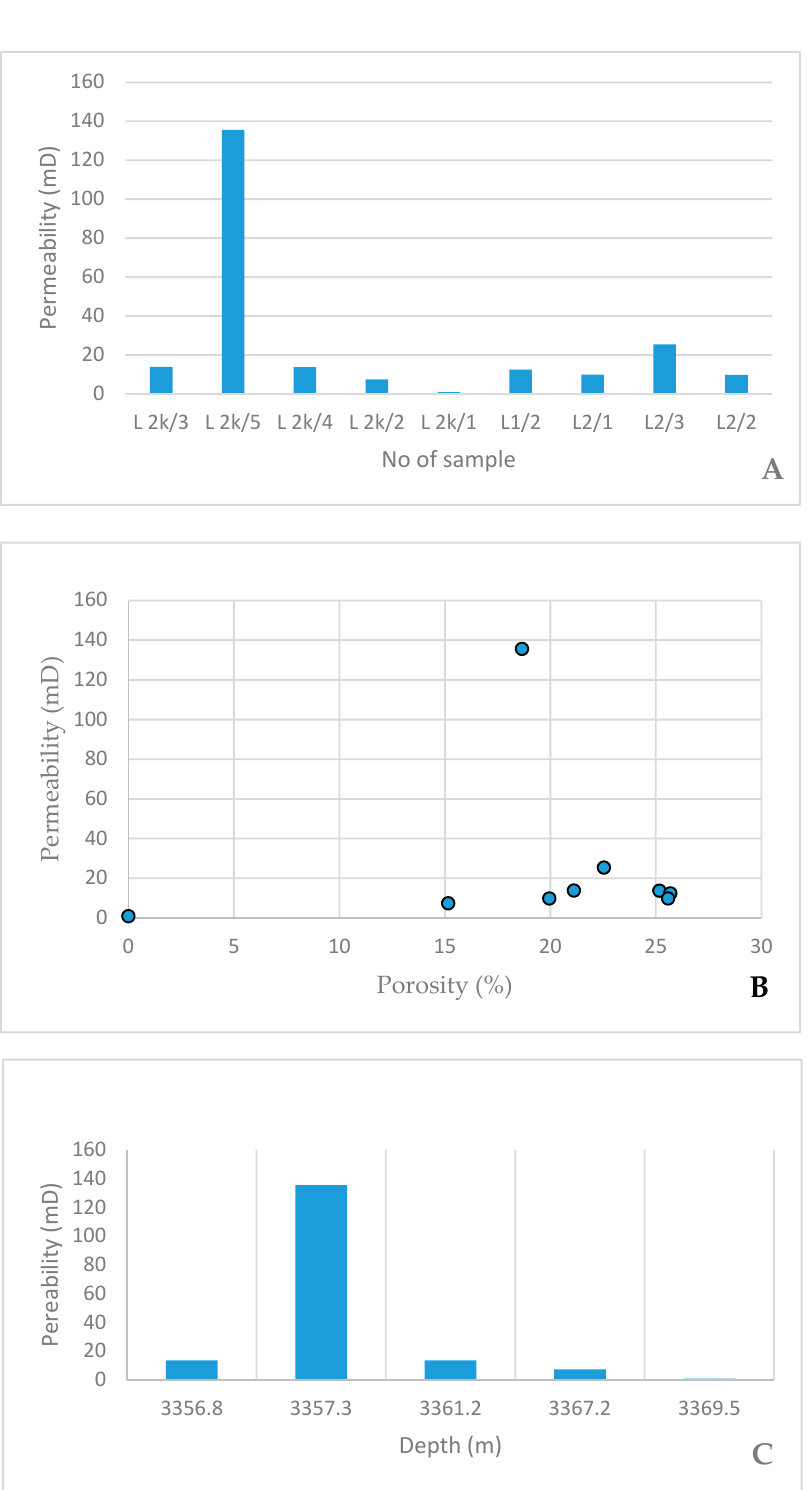
Figure 3. A – Value of permeability in all samples; B - permeability variation related to porosity; C – Figure 3. A —Value of permeability in all samples; B —permeability variation related to porosity; permeability variation to depth in L 2k. C —permeability variation to depth in L